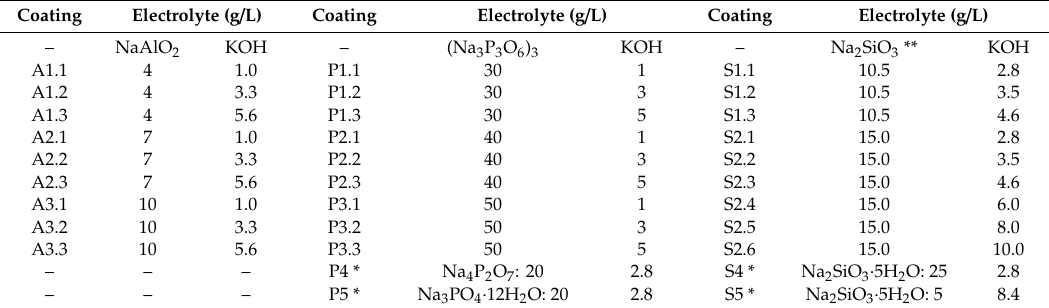
Table 1. PEO conditions of AA1050 alloy.